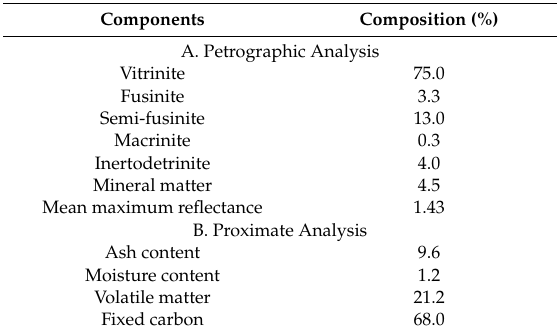
Table 1. Properties of the coal